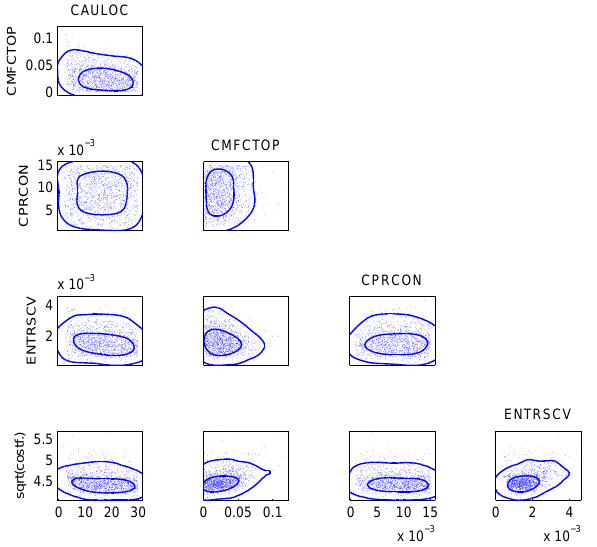
Fig. 5. Pairwise MCMC chain plots for the J G + ZONAL cost func- tion. The first 1000 points are removed as burn-in time, as in the histograms of Fig. 4. The contours estimate 50% and 95% poste- rior probability levels of the marginal 2 dimensional distributions. Note that in addition to the four model parameters, the square root of value of the cost function is included as the fifth chain member.